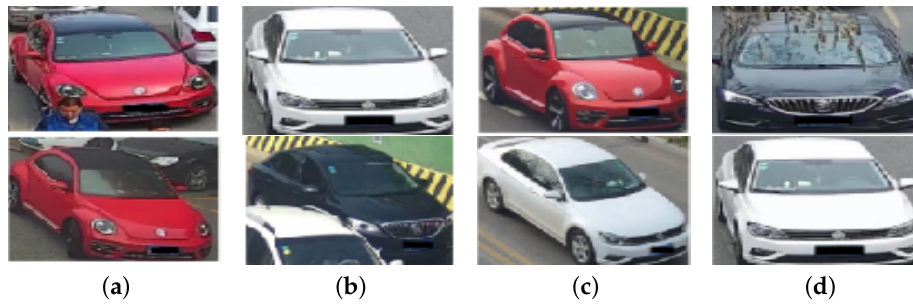
Figure 12. Traffic scene images of UA-DETRAC data set, where ( a – d ) are images of different vehicles in a traffic scene.